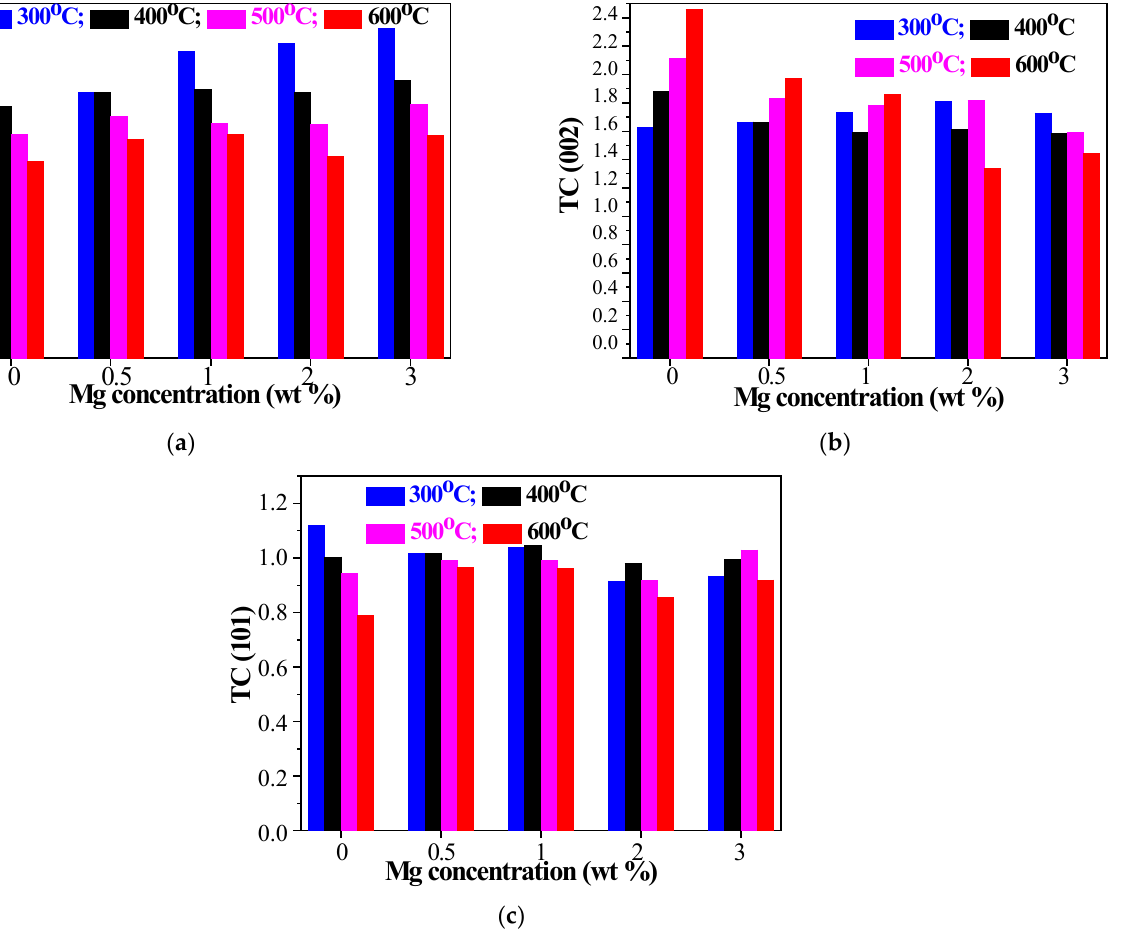
Figure 5. Texture coefficients of ZnO and ZnO:Mg films, depending on the thermal treatments and magnesium doping: ( a ) TC (100), ( b ) TC (002) and ( c ) TC (101).